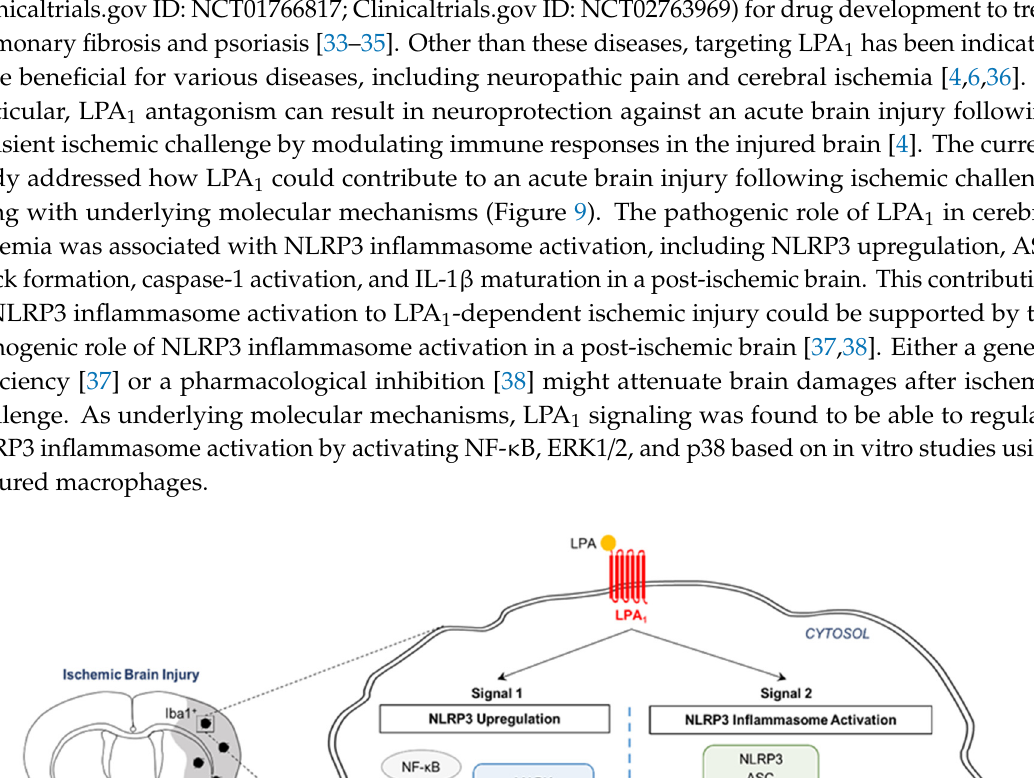
BMDMs based on Western blot analysis. Representative blots and quantification data are shown. Cells were treated with each inhibitor for 30 min prior to LPS priming. n = 3 per group. *** p < 0.001 versus control BMDMs (Veh). ## p < 0.01 and ### p < 0.001 versus stimulated BMDMs (LPS + LPA). ( b - d ) Effects of LPA 1 antagonist on activation of p38 or ERK1 / 2 in LPS-primed BMDMs determined by Western blot analysis. Representative Western blots of phosphorylated p38 (p-p38), total p38 (p38), phosphorylated ERK1 / 2 (pERK1 / 2), total ERK1 / 2 (ERK1 / 2), and β -actin ( b ) and quantification of activation of p38 ( c ) and ERK1 / 2 ( d ) are shown. n = 3 per group. * p < 0.05 and ** p < 0.01 versus control BMDMs (Veh).